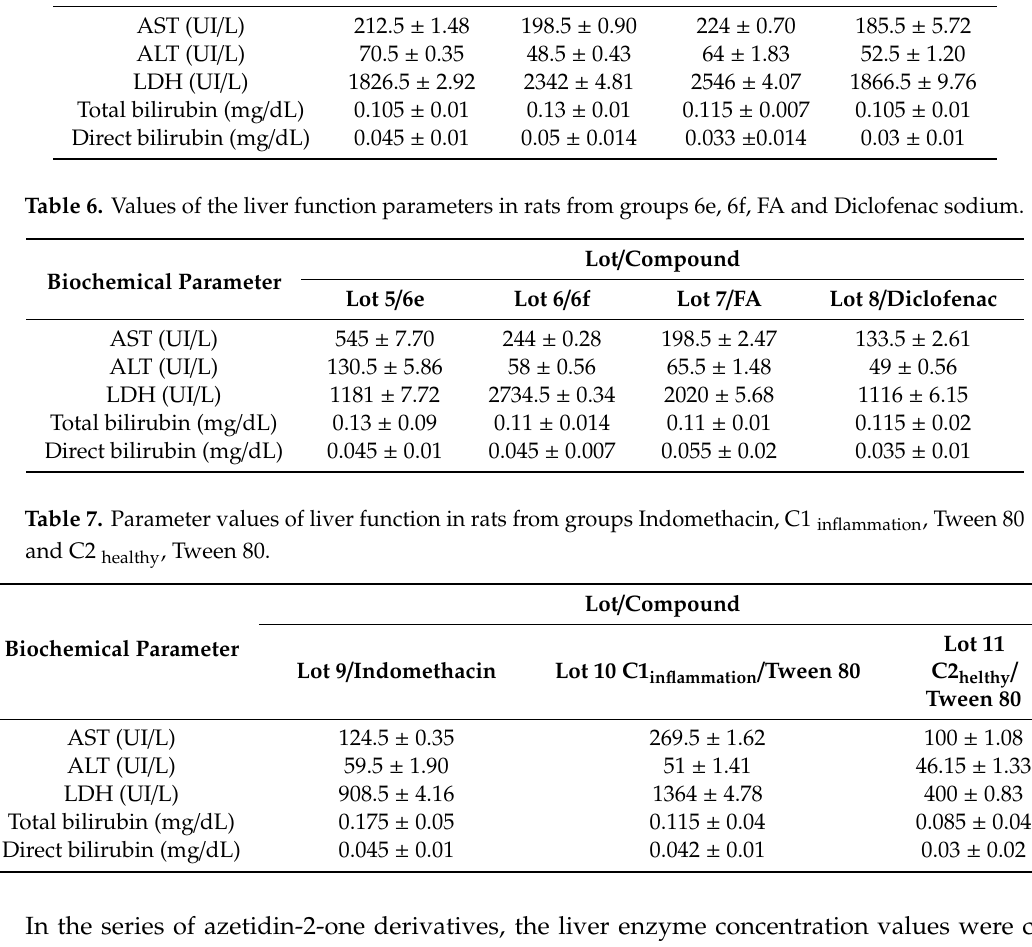
Table 5. Values of liver function parameters in rat lots 6a , 6b , 6c , and 6d . Biochemical Parameter